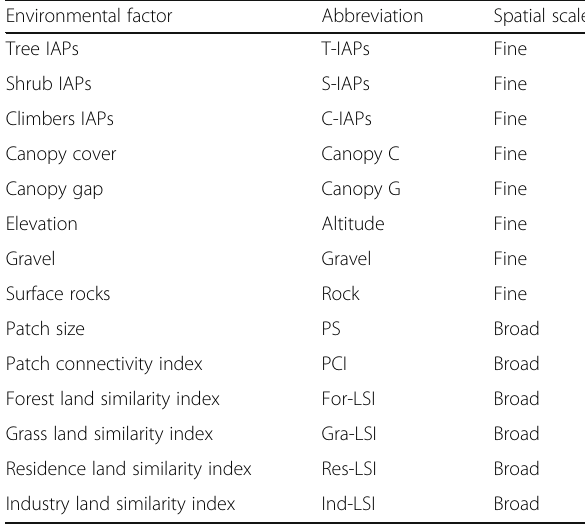
Table 2 Environmental factors (and their abbreviations) used in the current study along with a description of their geographic scale. The fine scale refers to plot area (100 m 2 ), and the broad scale refers to patch size (ranges from 9.5 to 787